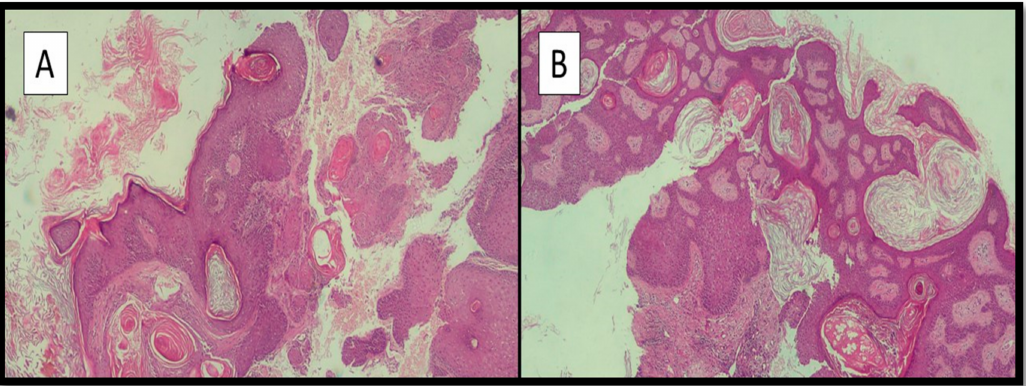
Figure 2. ( A , B ) Photomicrograph showing the histological characteristics of the lesions described in the main text: areas of acanthosis with hypergranulosis are noted (hematoxylin-eosin, original magnification 10 ×